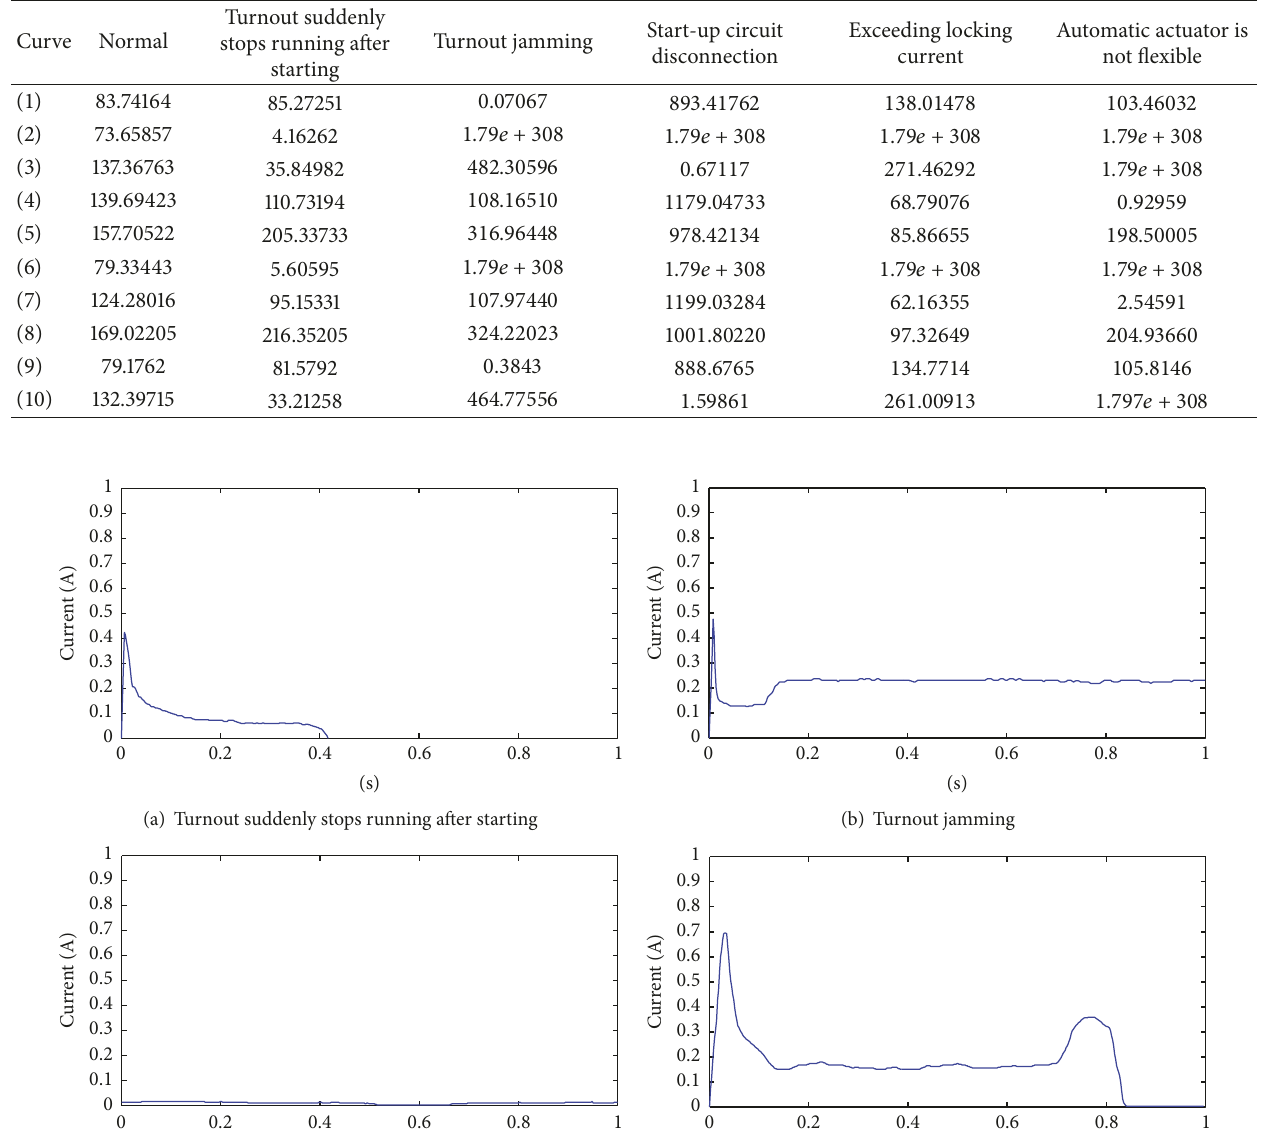
Table 1: The distance between test samples and reference templates.